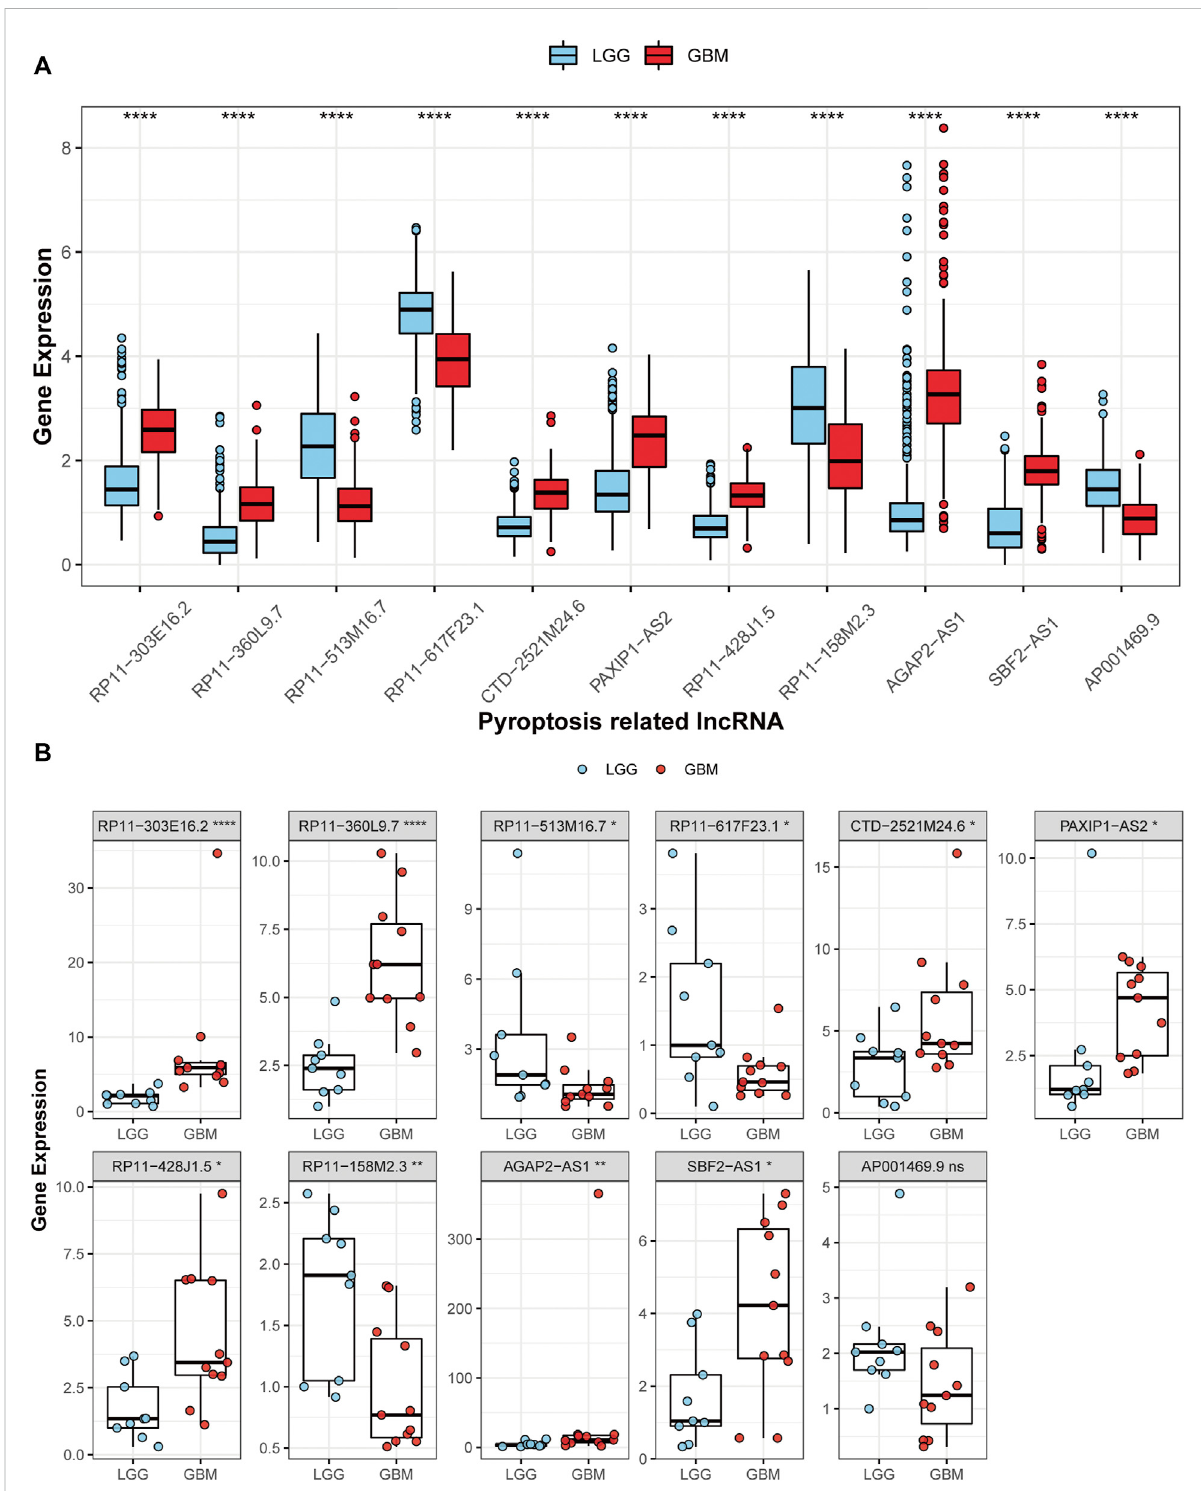
FIGURE 9 Validation of the 11 PRL expression levels. (A) The 11 PRL expression levels between LGGs and GBMs in TCGA cohort. (B) Expression analysis of the 11 PRLs in 9 LGG and 11 GBM samples. * p < 0.05, ** p < 0.01, and *** p < 0.001. ns, no signi fi